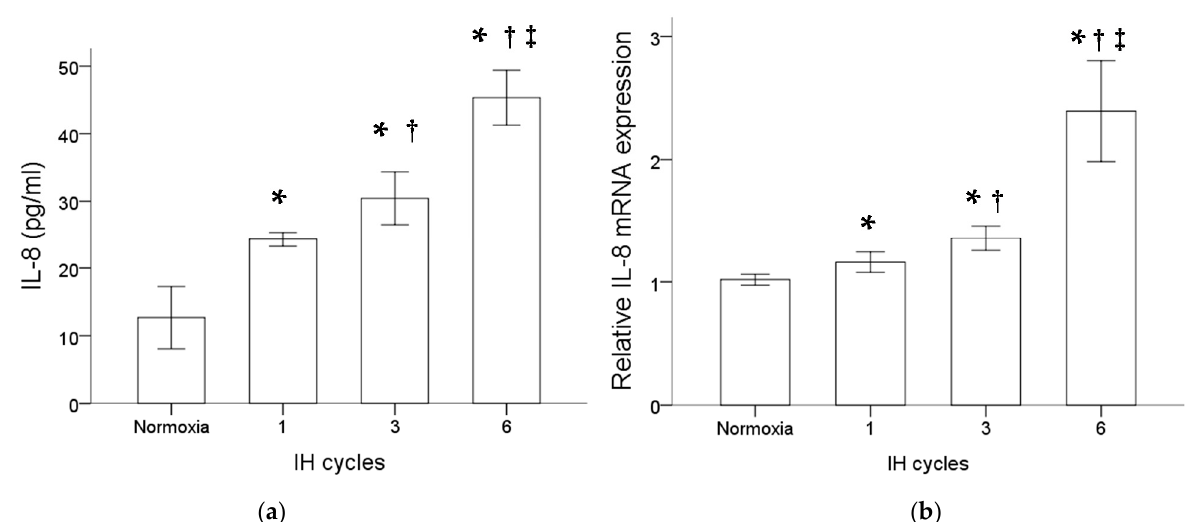
Figure 1. Intermittent hypoxia enhanced IL-8 protein secretion and gene expression in monocytes. THP-1 cells were treated with normoxia or intermittent hypoxia for one, three and six cycles as described in the Methods. ( a ) Secreted IL-8 protein was detected in the culture medium using the enzyme-linked immunosorbent assay. ( b ) RNA was isolated for the analysis of IL-8 gene expression by RT/real-time PCR. Note: The data are presented as the means and the standard errors of three independent experiments, * p < 0.05 vs. normoxia; † p < 0.05 vs. one IH cycle; ‡ p < 0.05 vs. three IH cycles. Abbreviations: IH = intermittent hypoxia; IL = interleukin.